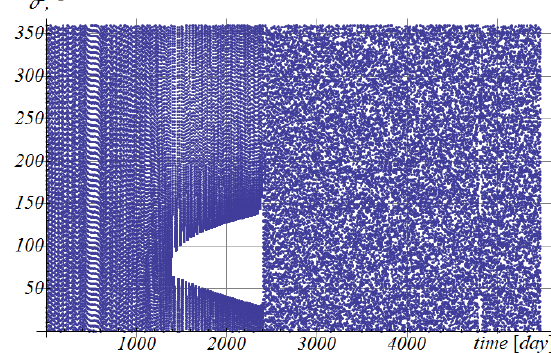
Figure 10. Evolution of angle σ in scenario 3.